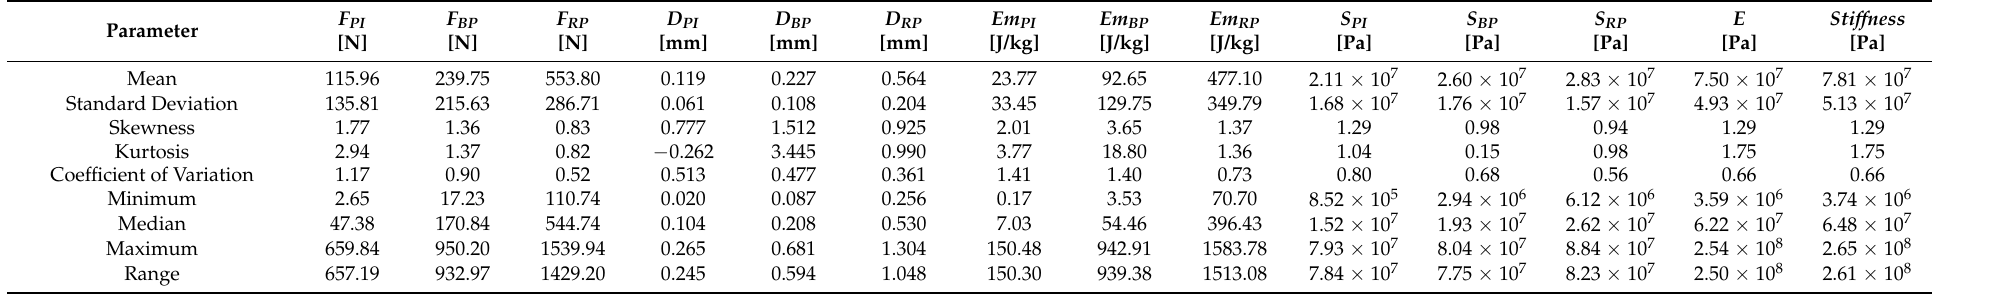
Table 5. Results of statistical analysis of the examined selected physical properties of corn